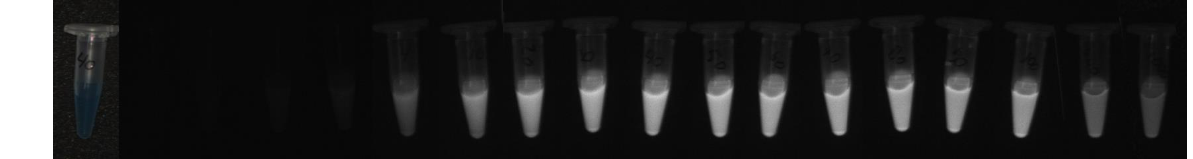
Figure 3. Dilution series of methylene blue visualized by fluorescence imagining device.